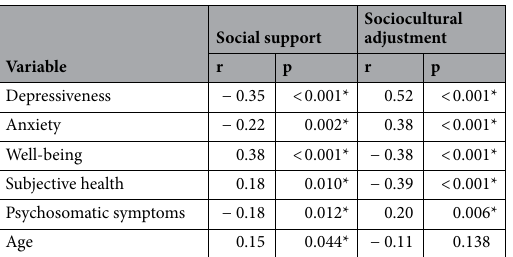
Table 5. Correlations between social, mental health and well-being indicators. *p < 0.05.